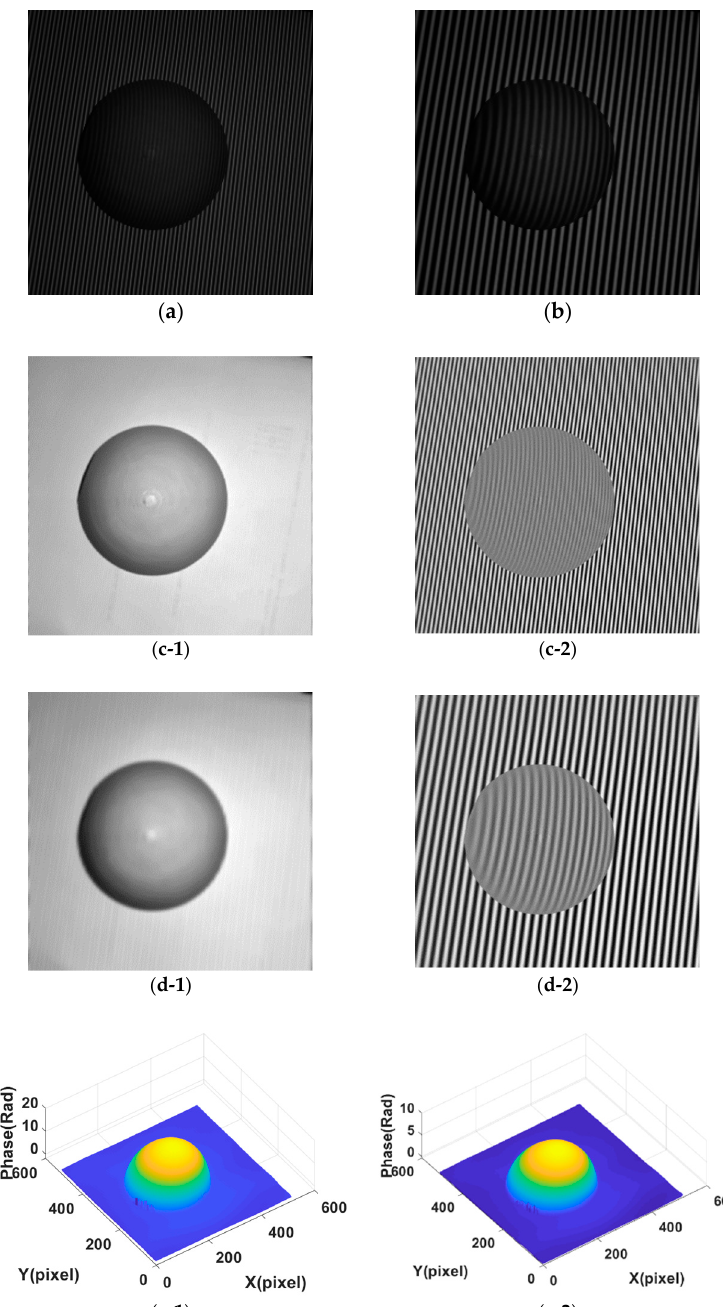
Figure 3. Experimental projection fringe patterns. ( a ) Fringe pattern with larger frequency; ( b ) Fringe pattern with small frequency. ( c-1 ) The ground truth background part of Figure 3a; ( c-2 ) The ground truth fringe part of Figure 3a; ( d-1 ) The ground truth background part of Figure 3b; ( d-2 ) The ground truth fringe part of Figure 3b; ( e-1 ) The ground truth phase for Figure 3a; ( e-2 ) The ground truth phase for Figure 3b.